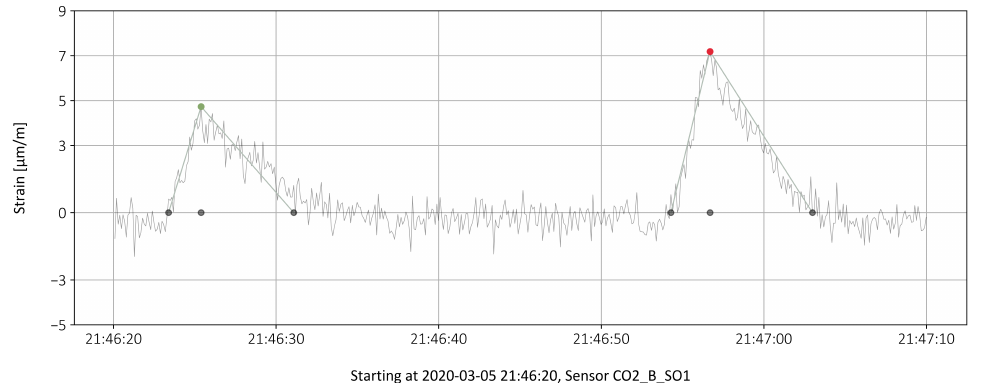
Figure 3. Reference measurement of the strain, a 24-tonne truck (left) followed by a 40-tonne truck, with points of interest